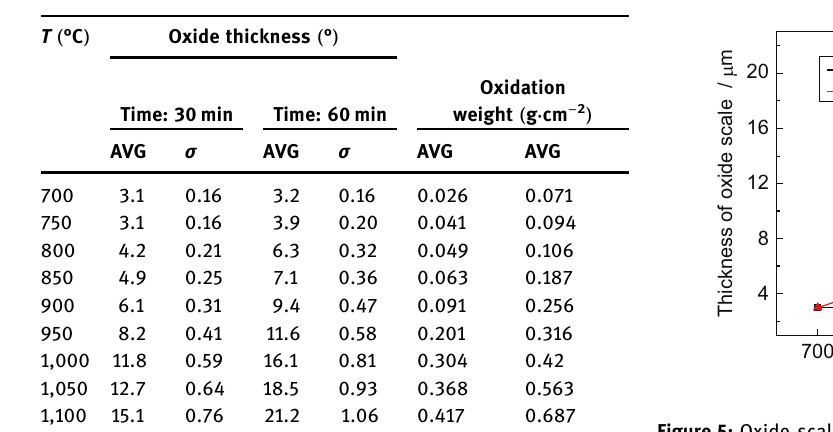
Table 3: Thickness of oxide scale and detection value of oxidation weight